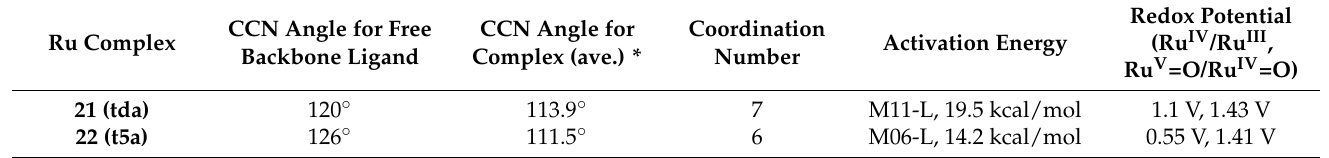
Table 3. Comparison of complexes 21 and 22 that contain similar backbone